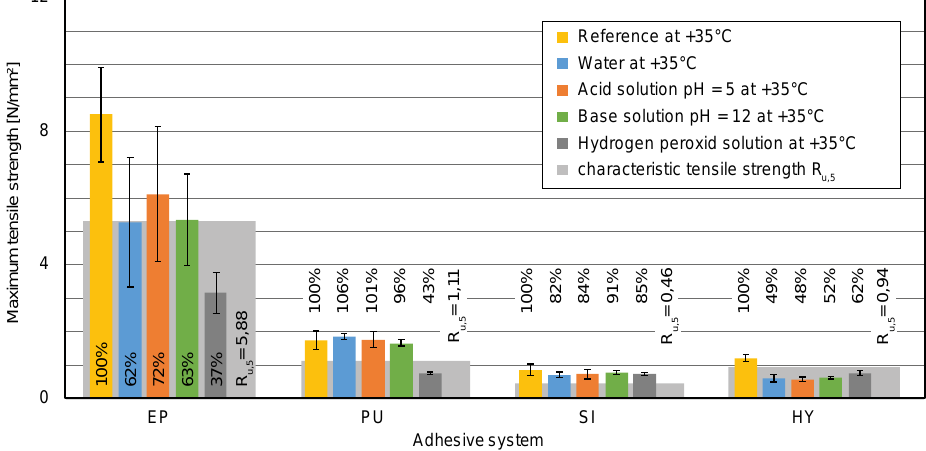
Figure 8: Mean and characteristic maximum tensile strength of adhesive specimens after chemical